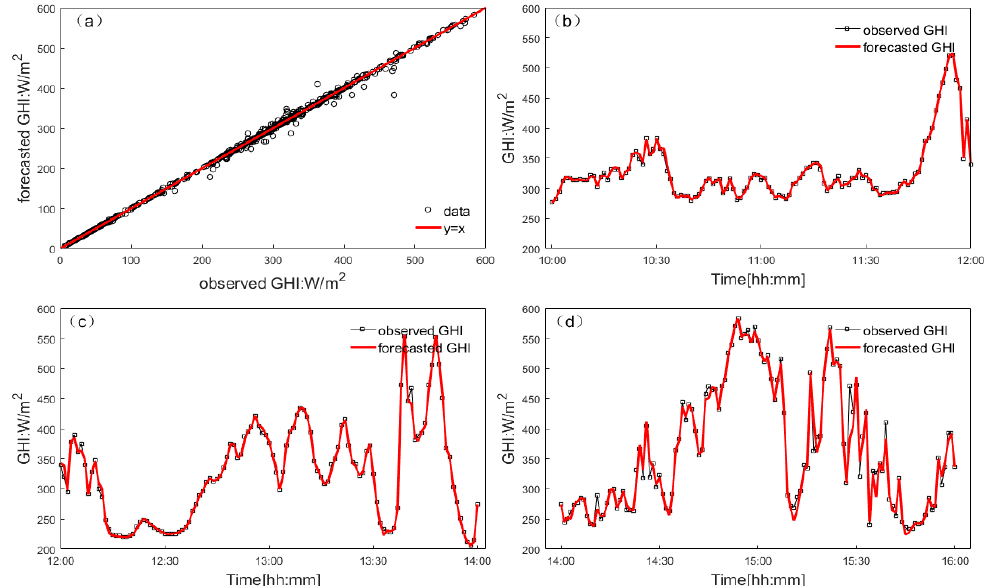
Figure 10. Nowcasting irradiance scatter plots on ( a ) 7 November 2017, ( b ) 10:00—12:00 on 7 November 2017, ( c ) 12:00—14:00 on 7 November 2017, ( d ) 14:00—16:00 on 7 November 2017.